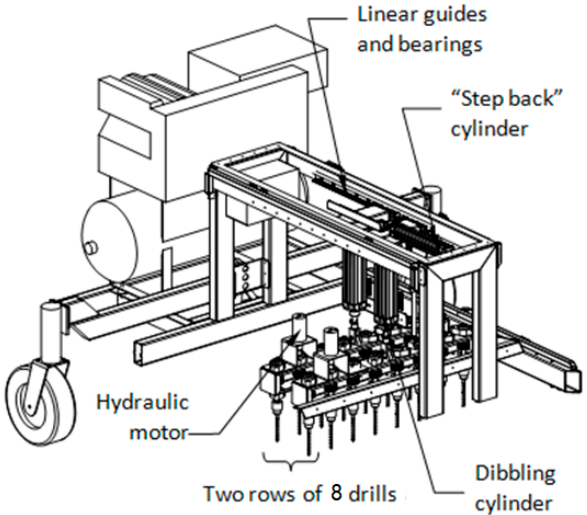
Figure 9. The dibbling mechanism (part of the base frame is hidden for clarity).